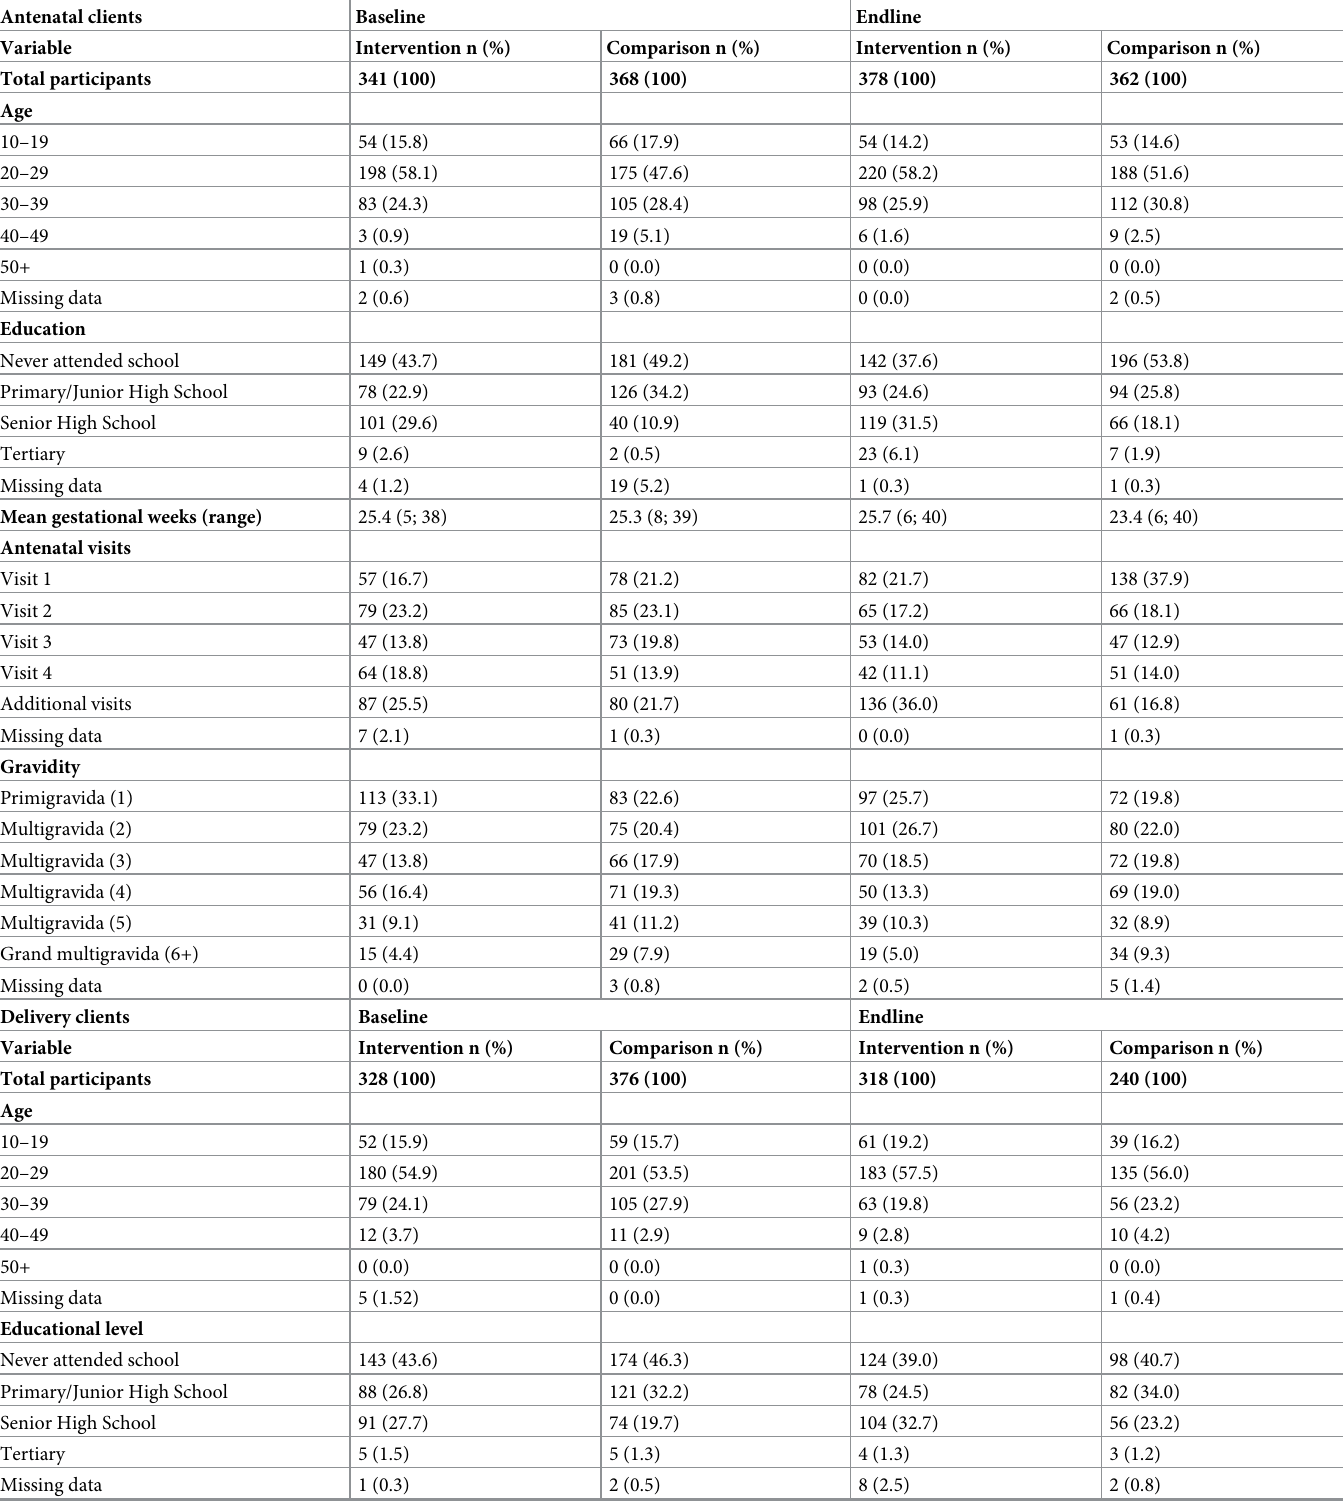
Table 1. Demographic characteristics of antenatal and delivery clients at baseline and